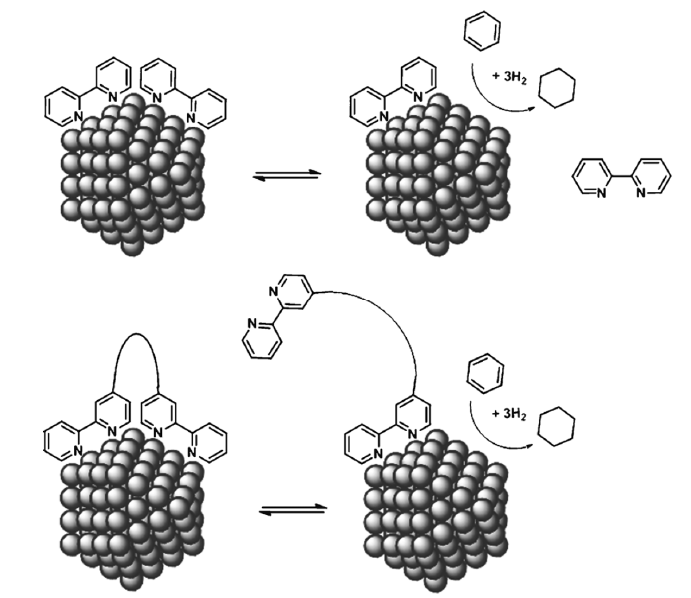
Figure 5. Representation of the proposed role of bipy ( top ) and the [dibipy][NTf ( bottom ) during the NP-catalyzed hydrogenation of benzene, which accounts for the higher stability of the dimeric stabilizer. Reprinted from Ref. [67], with permission from